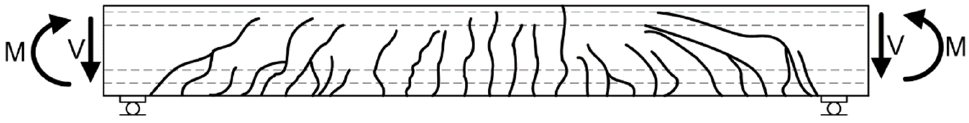
Figure 7. Macrocracks due to shear; M —as in Figure 5, V —shear force.